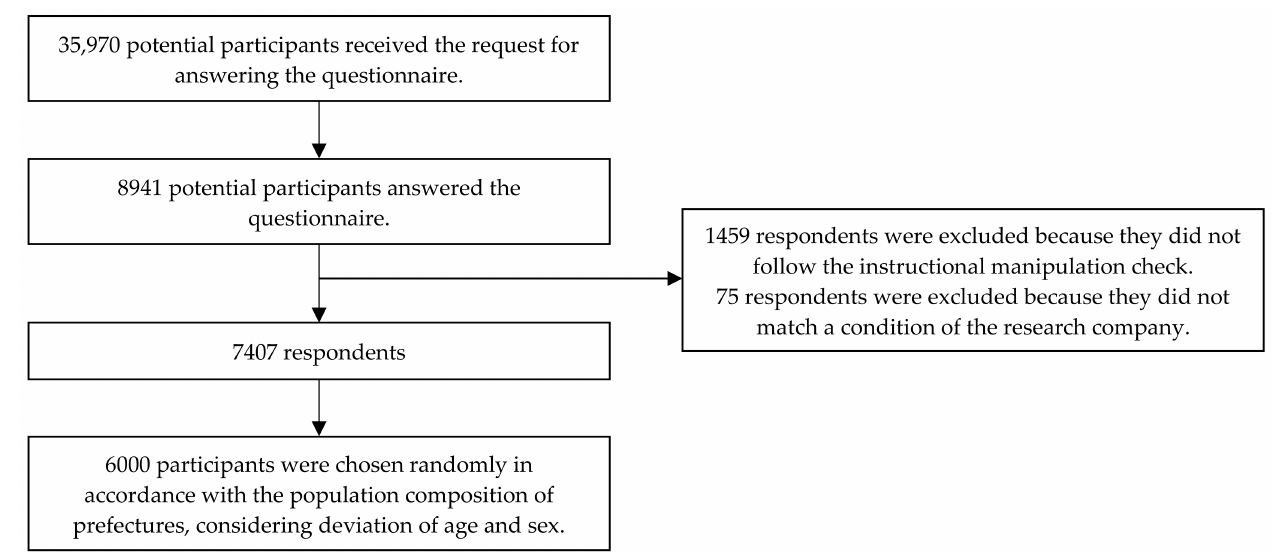
Figure 2. A flowchart of this